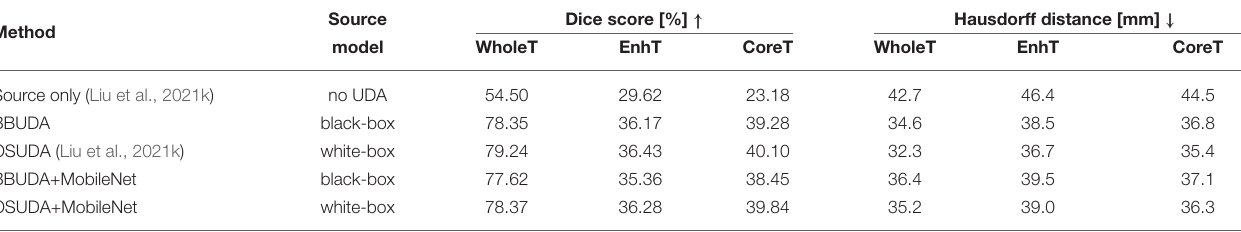
TABLE 3 | Comparison of T2 to T1 black-box